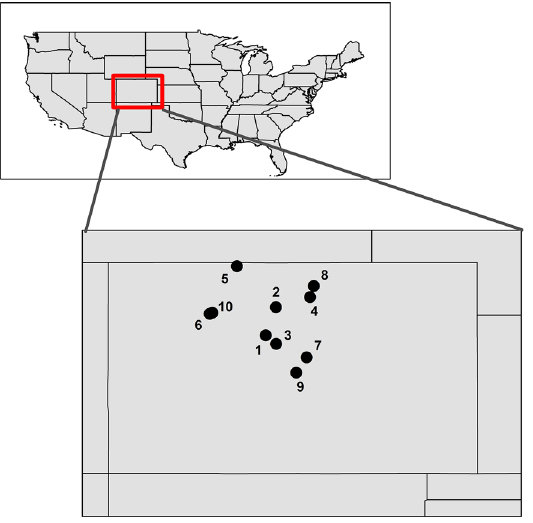
Fig 1. Map of waterbodies sampled for eDNA detection of M . diluviana in Colorado, USA. Numbers correspond to Map ID in Table